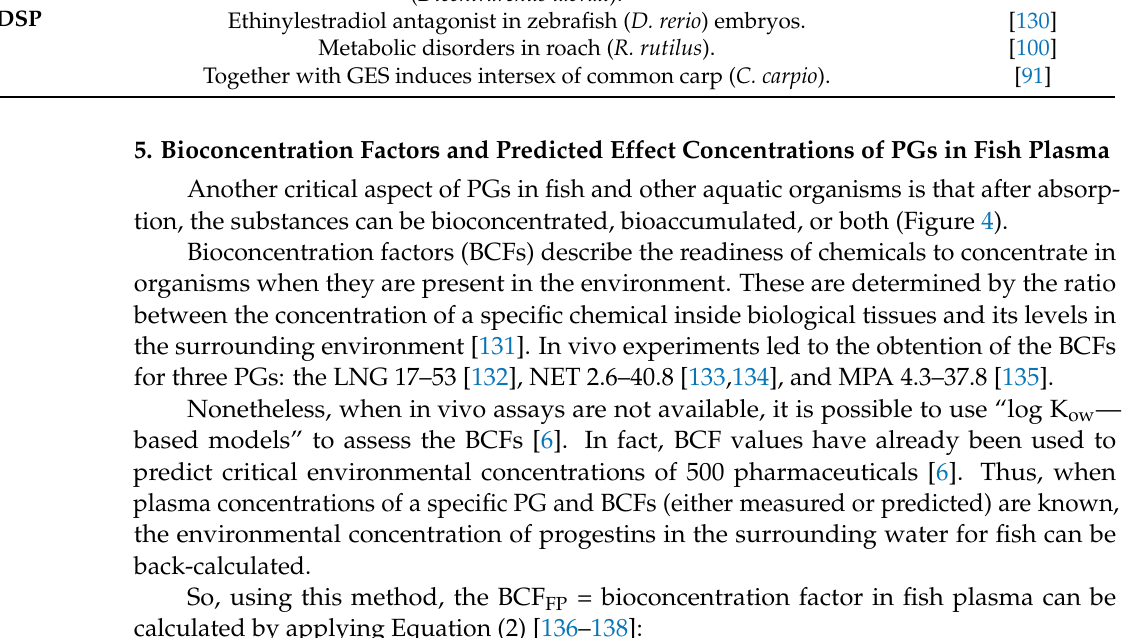
Table 5. Cont. Structural or Functional Impact on Fish Alter plasma steroid levels and CYP 17 A 1 expression in gonads of juvenile sea bass ( Dicentrarchus labrax ). DSP Ethinylestradiol antagonist in zebrafish ( D. rerio ) embryos. o r Metabolic disorders in roach ( R. rutilus Sp i